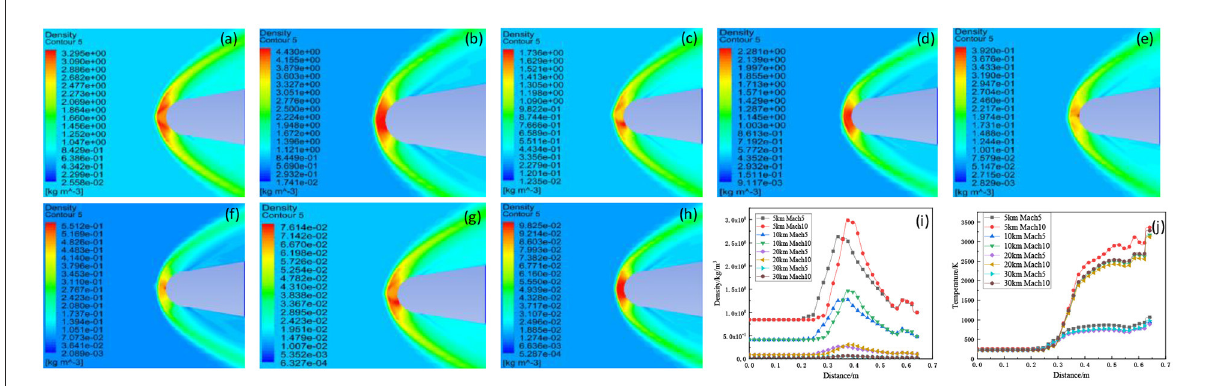
FIGURE3 Comparison of density distribution of disturbed flow field of hypersonic vehicle at different flight speeds and altitudes (a) Flight altitude 5km flight speed Mach 5. (b) Flight altitude 5km flight speed Mach 10. (c) Flight altitude 10km flight speed Mach 5. (d) Flight altitude 10km flight